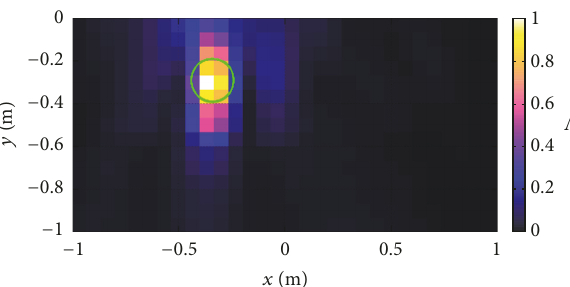
Figure 5: Spatial distribution of the normalized object function Λ in the investigation domain 𝐷 inv , for SNR = 10 dB [96].